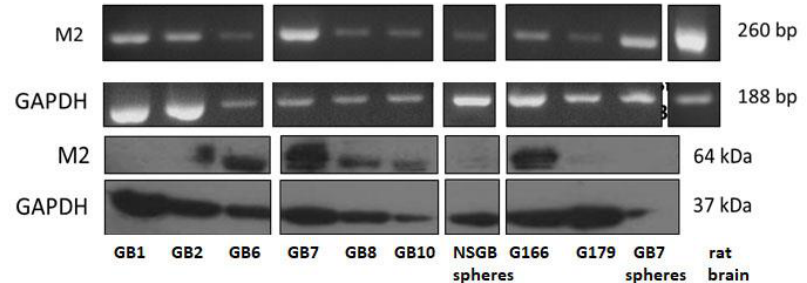
Figure 1. M2 protein expression in different GSC lines. Upper panels RT-PCR analysis; Lower panels Western blot analysis. GAPDH was used as an internal reference for transcript and protein analysis.